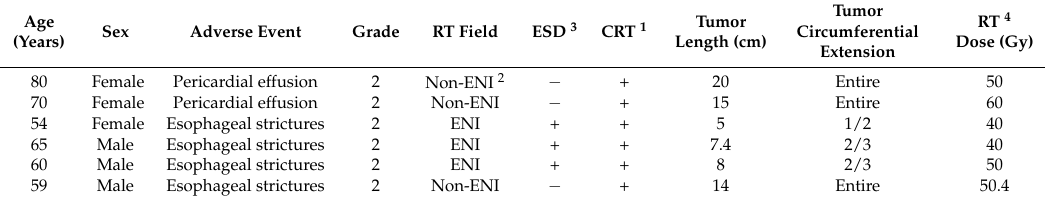
Table 5. The summary of late toxicities of a grade ≥ 2 in the study